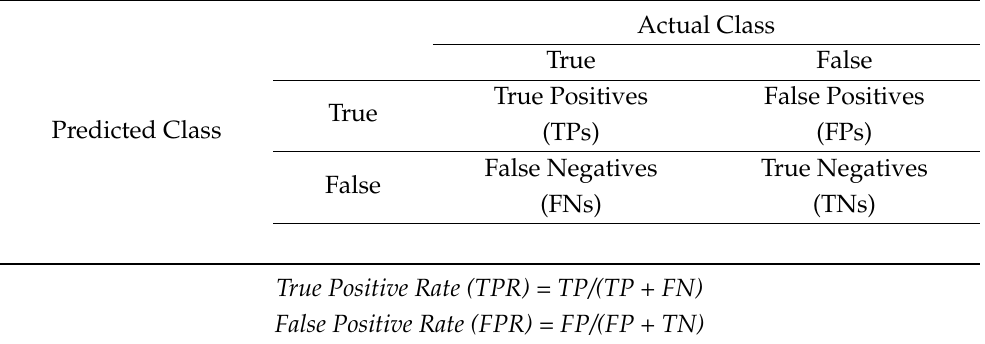
Table 14. Confusion matrix and related evaluation